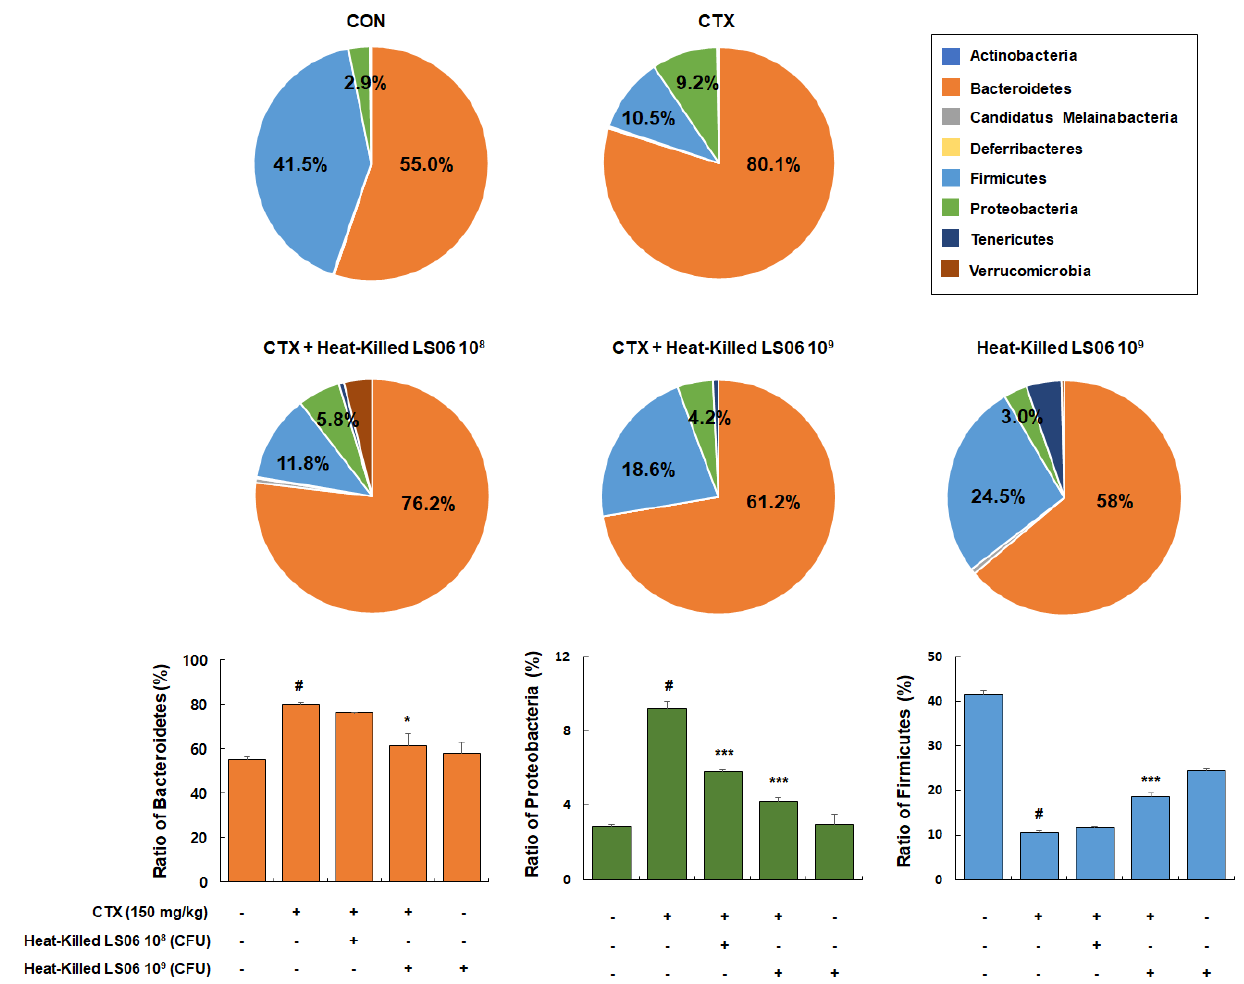
Figure 8. Effects of heat-killed LS06 treatment on the composition of microbiota in CTX-treated mice. Genomic DNA was analyzed for bacterial composition using 16S rRNA gene sequencing. Data are presented as mean ± SEM ( n = 10). # p < 0.05 vs. Con group; * p < 0.05 and *** p < 0.001 vs. CTX group.